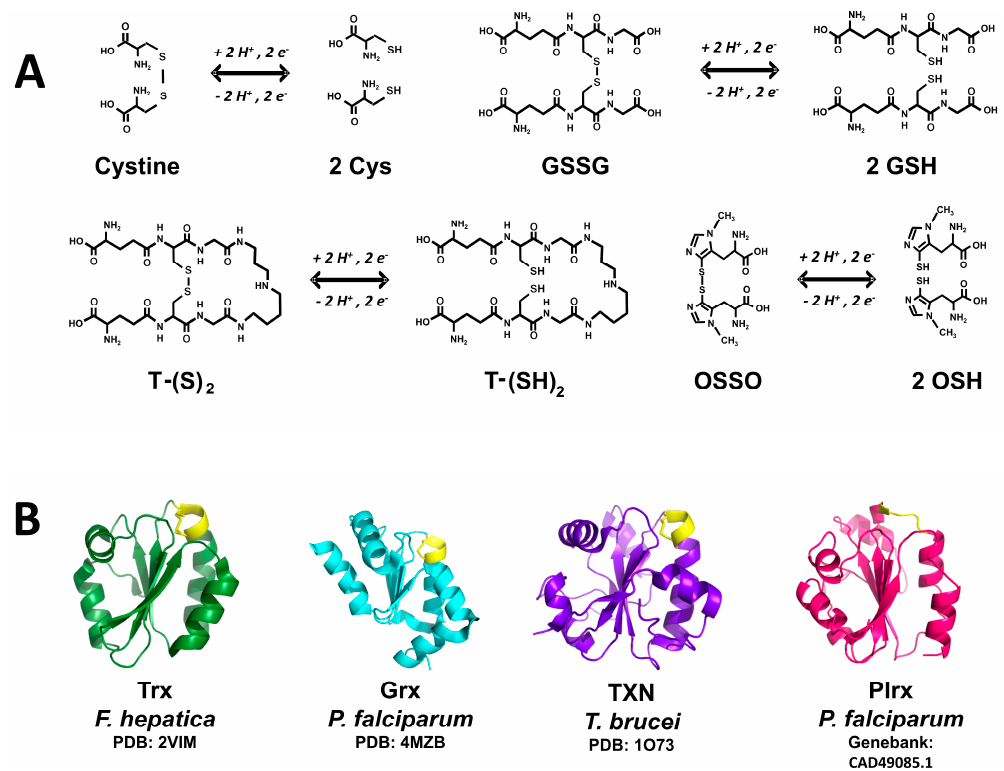
Figure 2 . Diversity of thiol-containing redox substrates in invertebrate parasites. ( A ) The thiol-containing substrates of low molecular weight cysteine (Cys), glutathione (GSH), trypanothione (T-SH 2 ) and ovothiol (OSH) are shown. Both the reduced and the disulfide form of each compound is shown; ( B ) Schematic representation of the three-dimensional structure of the thiol-containing substrates of protein nature as thioredoxin (Trx), glutaredoxin (Grx), tryparedoxin (TXN), and Plasmoredoxin (Plrx). Active sites are shown in yellow. For Trx, Grx, and TXN the corresponding PDB file is indicated. The model corresponding to Plrx was constructed from the amino acid sequence data base by using the automatized SWISS-MODEL server (http://swissmodel.expasy.org). Models were drawn with PyMOL.